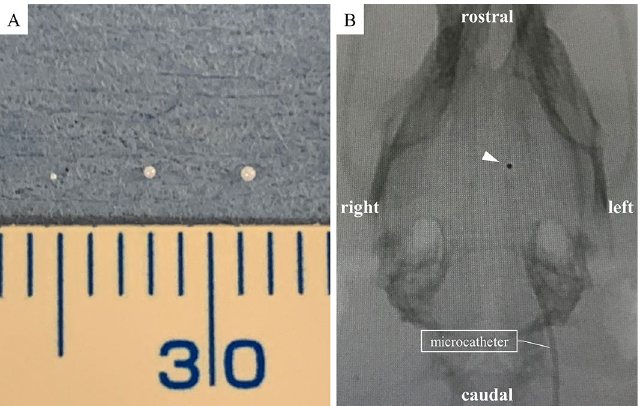
Figure 4. ( A ) Three sizes of zirconia ball. From left to right: 0.2 mm, 0.4 mm and 0.5 mm in diameter. The zirconia ball used in the stroke model was 0.4 mm in diameter. ( B ) Fluoroscopy shows the anterior cerebral artery-middle cerebral artery bifurcation that was selectively embolized by one zirconia ball 0.4 mm in diameter (arrowhead). The site of embolization can be easily identified during fluoroscopy because of the high visibility of zirconia